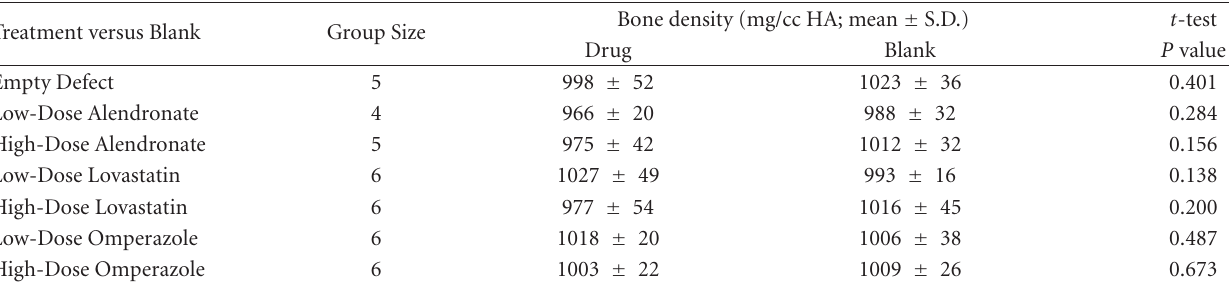
Table 3: E ff ects of Drug Therapy on New Bone Density (mg/cc